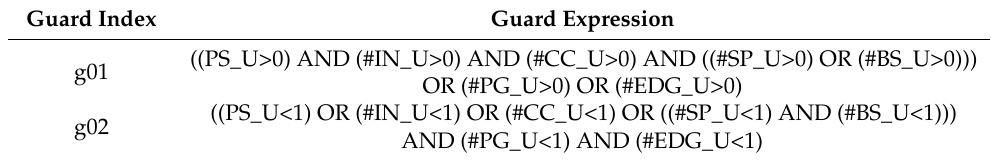
Table 4. New guard expressions for the model B